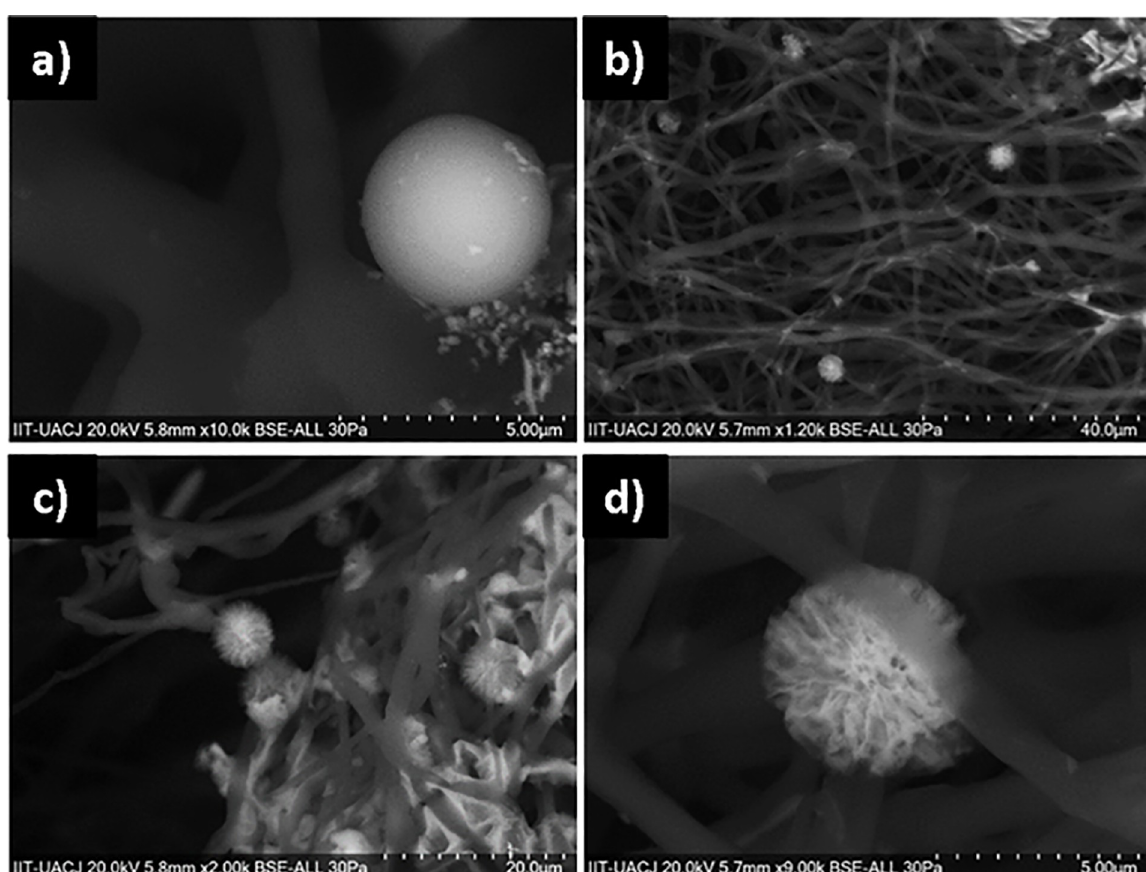
Fig 6. Inhibition effect of PCL-CuONPs against C . glabrata . a) and b) are images for C . glabrata exposed to plain PCL, and c) and d) are images of C . glabrata exposed to PCL-CuONPs at 200 mM.